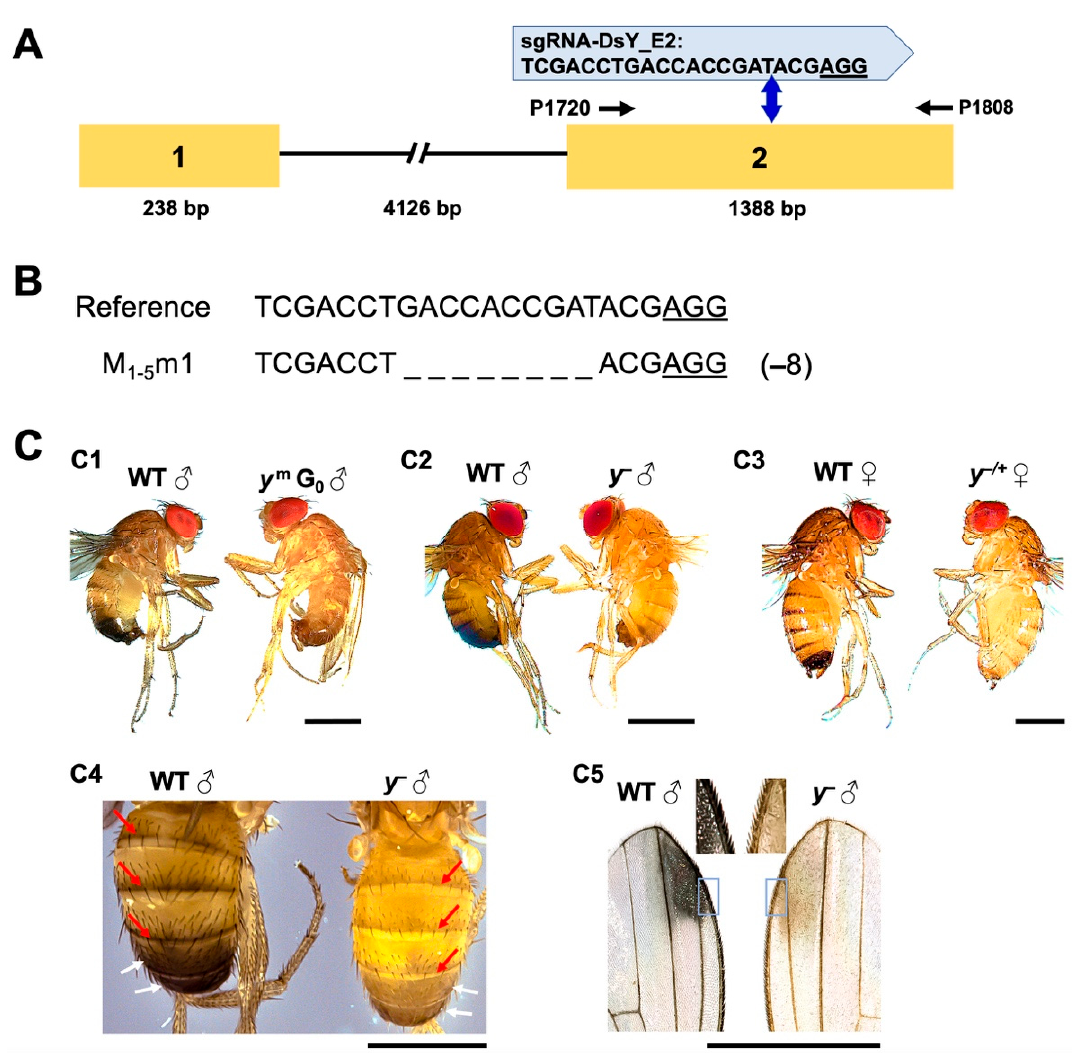
Figure 4. Targeted mutation in an endogenous yellow gene ( DsY ) using Cas9-expressing D. suzukii . ( A ) Schematic of DsY genomic organization with exons as numbered yellow boxes and intron as lines (not to scale). The PAM sequence is underlined. The predicted DSB site is indicated by blue double-headed arrows. Genotyping primers are indicated as black arrows. ( B ) Alignment of a DsY mutant allele isolated from DsY − flies compared to the WT (reference) sequence. The origin is shown on the left, and the numbers of deleted nucleotides (_) indicated in the brackets on the right. ( C ) Comparison between the WT (left position in each image) and DsY − mutant (right position in each image) phenotypes. Nearly whole-body mosaic yellow phenotype ( DsY m ) was observed in G 0 flies ( C1 ), and male mutants with the whole-body yellow phenotype ( DsY − ) were obtained at G 1 ( C2 ). Female heterozygous mutants ( DsY − /+ ) were also obtained at G 1 , which showed a more yellowish pigmentation compared to WT females ( C3 ). The tan pigments present in midline stripes (indicated by red arrows) and abdominal sixth and seventh segments (indicated by white arrows) from DsY − males suggest the Yellow protein was absent throughout the abdominal tergite ( C4 ). WT flies are a uniform color in the wing background, spot area, and trichomes, while these structures become tan and yellowish in the DsY − males ( C5 ). Higher resolution views of the regions were boxed. Scale bar: 1 mm.